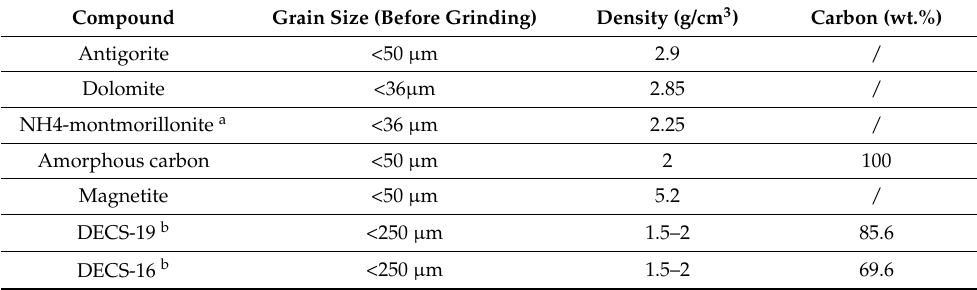
Table 1. Characteristics of the end-members used for spectral fitting: grains size, density, and carbon content.